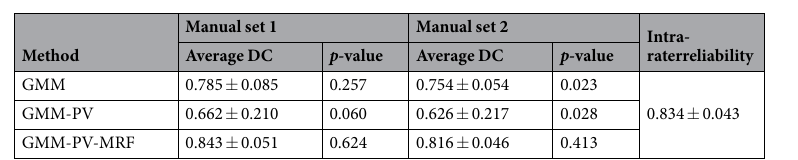
Table 5. Average Dice coefficients (DCs) ( ± standard deviations) for automatic segmentation of myelin-like signals in deep brain region of eight test subjects with respect to two sets of manual annotations compared to the intra-rater reliability. The p -values indicate the outcomes of two-tailed Student’s t -tests with the intra-rater DCs at the 5% significance level. The performance of GMM-PV-MRF is close to the intra-rater